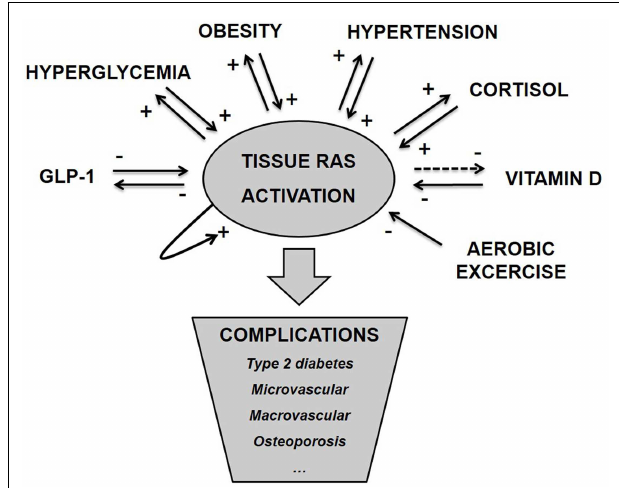
FIGURE 1 |Tissue RAS activity is controlled by several well-known metabolic hormones and conditions .This control often involves positive feedback mechanisms, which makes the basis for an unstable system and progression of disease.We hypothesize that metabolic complications arise as a consequence of pathological activated tissue